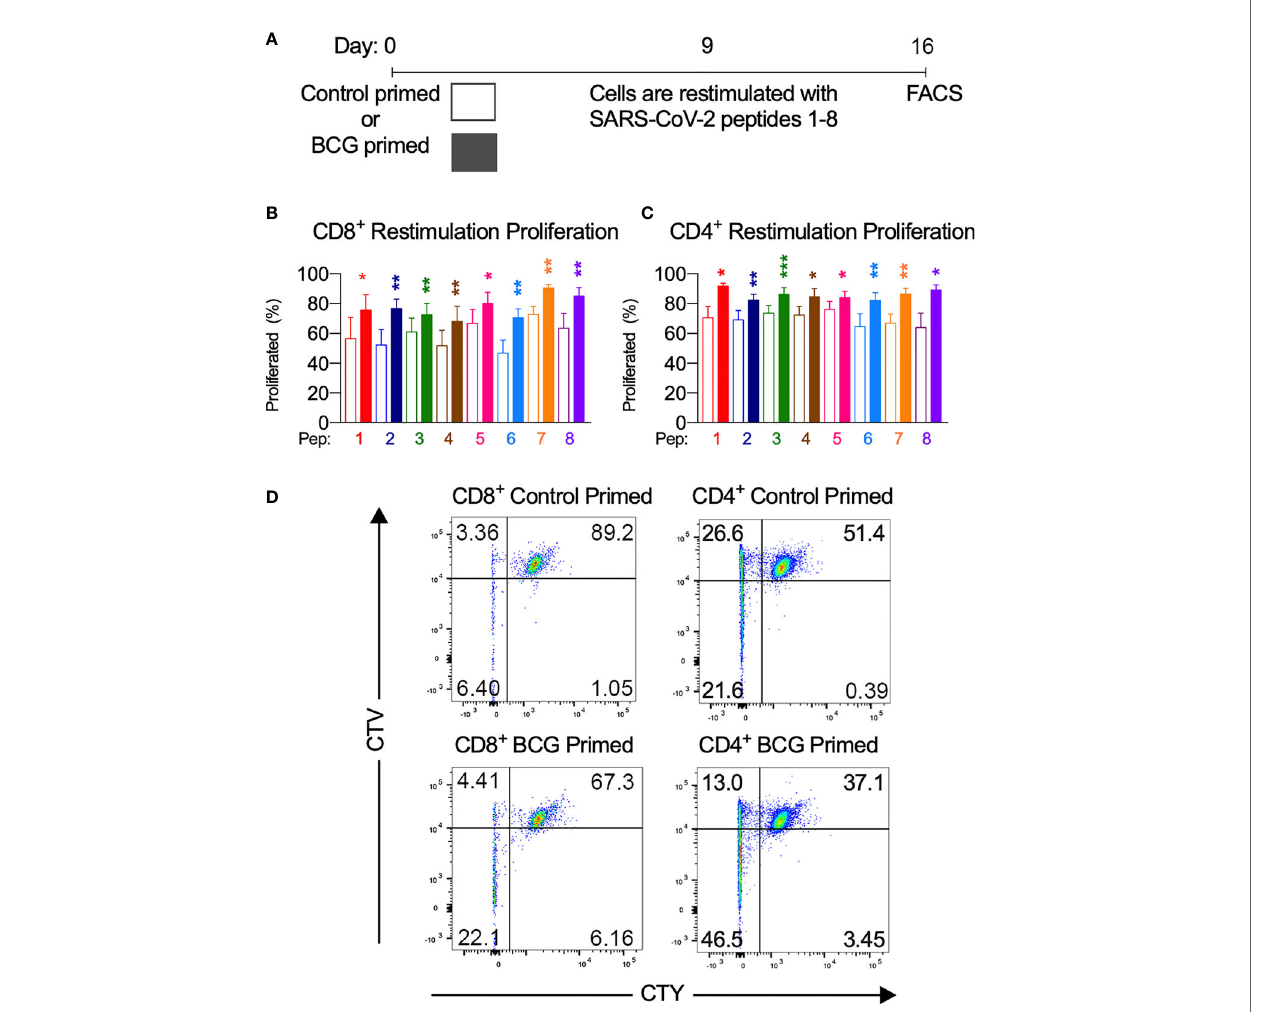
FIGURE 4 | BCG priming enhances T cell proliferation. (A) Brief culture timeline. (B) CD8+ restimulation proliferation is enhanced by BCG priming ( n =9-12). (C) CD4+ restimulation proliferation is enhanced by BCG priming ( n =6-11). Unshaded bars – Control-primed (irrelevant peptide, PVSKMRMATPLLMQA), then SARS-CoV-2- peptide restimulated. Shaded bars – BCG peptide primed then SARS-CoV-2-peptide homologue restimulated. (D) Representative CTV vs. CTY dot plots of CD4+ and CD8+ cultured cells indicating proliferation. Top right quadrant gate (CTY hi CTV hi cells) did not proliferate upon priming or restimulation. Top left quadrant gate (CTY lo CTV hi cells) proliferated upon priming but not with restimulation. Bottom left quadrant gate (CTY lo CTV lo cells) proliferated upon both priming and restimulation. * P <0.05, ** P <0.01, *** P <0.001 by Wilcoxon-matched-pairs-signed rank test, comparing the magnitude of response to SARS-CoV-2 peptides with or without BCG